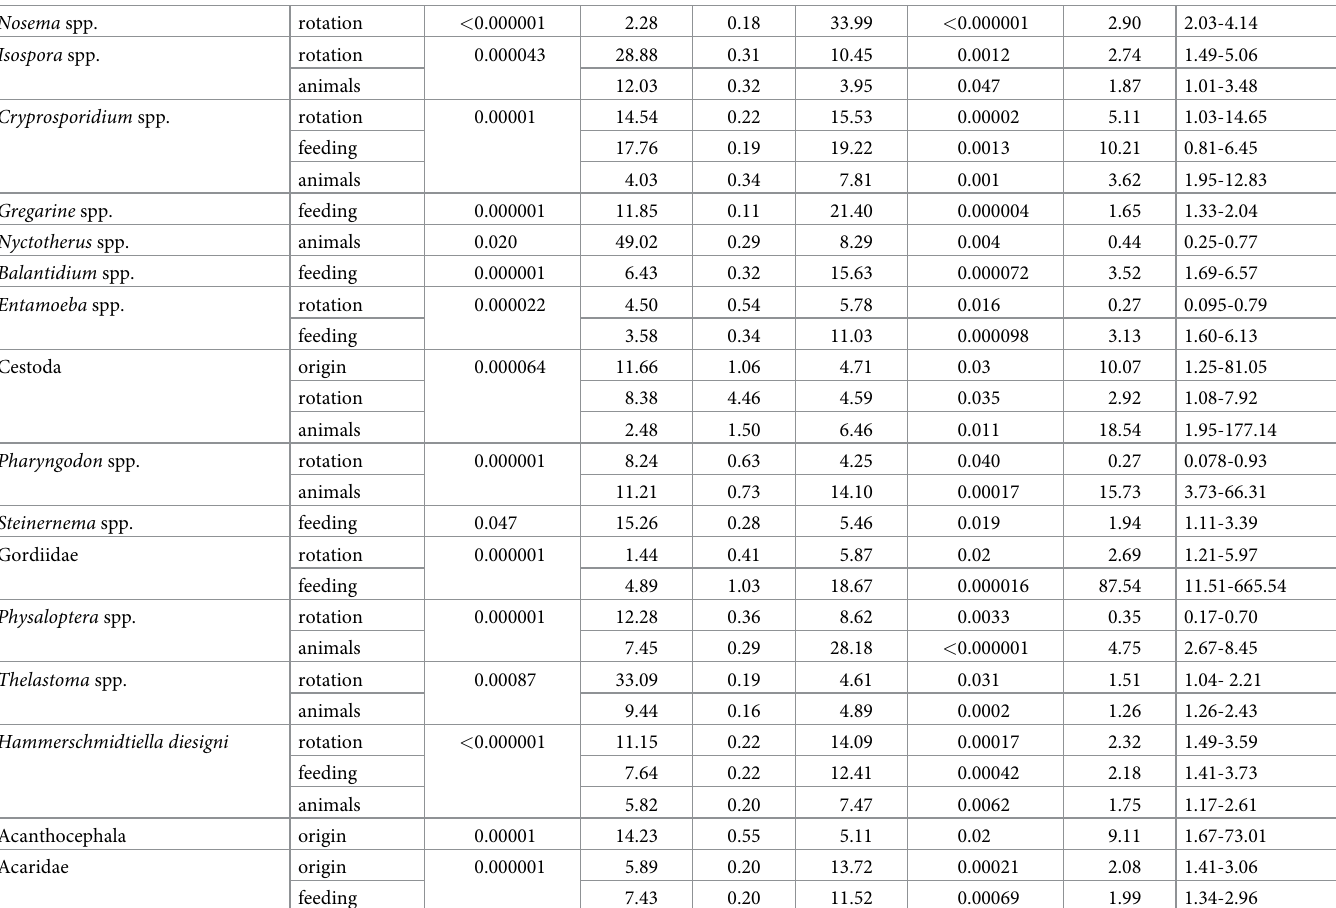
Table 2. Logistic regression model, showing statistically significant relationships between the parasite species and the origin of insects, insect stock rotation system, type of feeding and contact with animals. Nosema